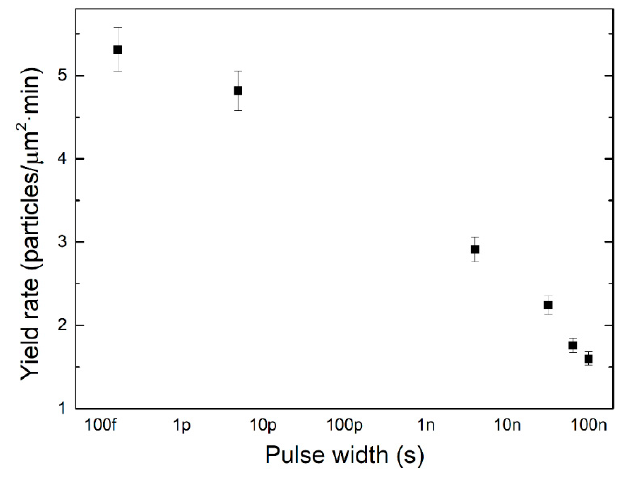
Figure 8. Nanoparticle yield rate as a function of the pulse width.